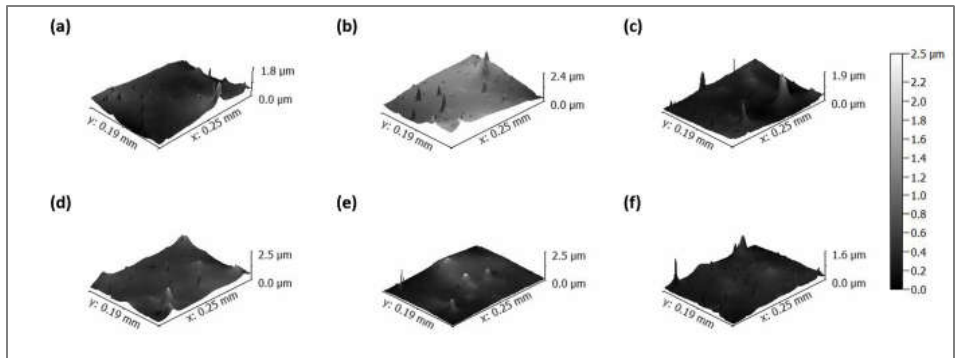
Figure 4. Surface topography of ( a ) non-activated PLA film, ( b ) oxygen plasma-activated PLA film, ( c ) plasma-activated PLA film with a gas mixture of 25% Ar + 75% O 2 , ( d ) plasma-activated PLA film with a gas mixture of 50% Ar + 50% O 2 , ( e ) plasma-activated PLA film with a gas mixture of 75% Ar + 25% O 2 , ( f ) argon plasma-activated PLA film.